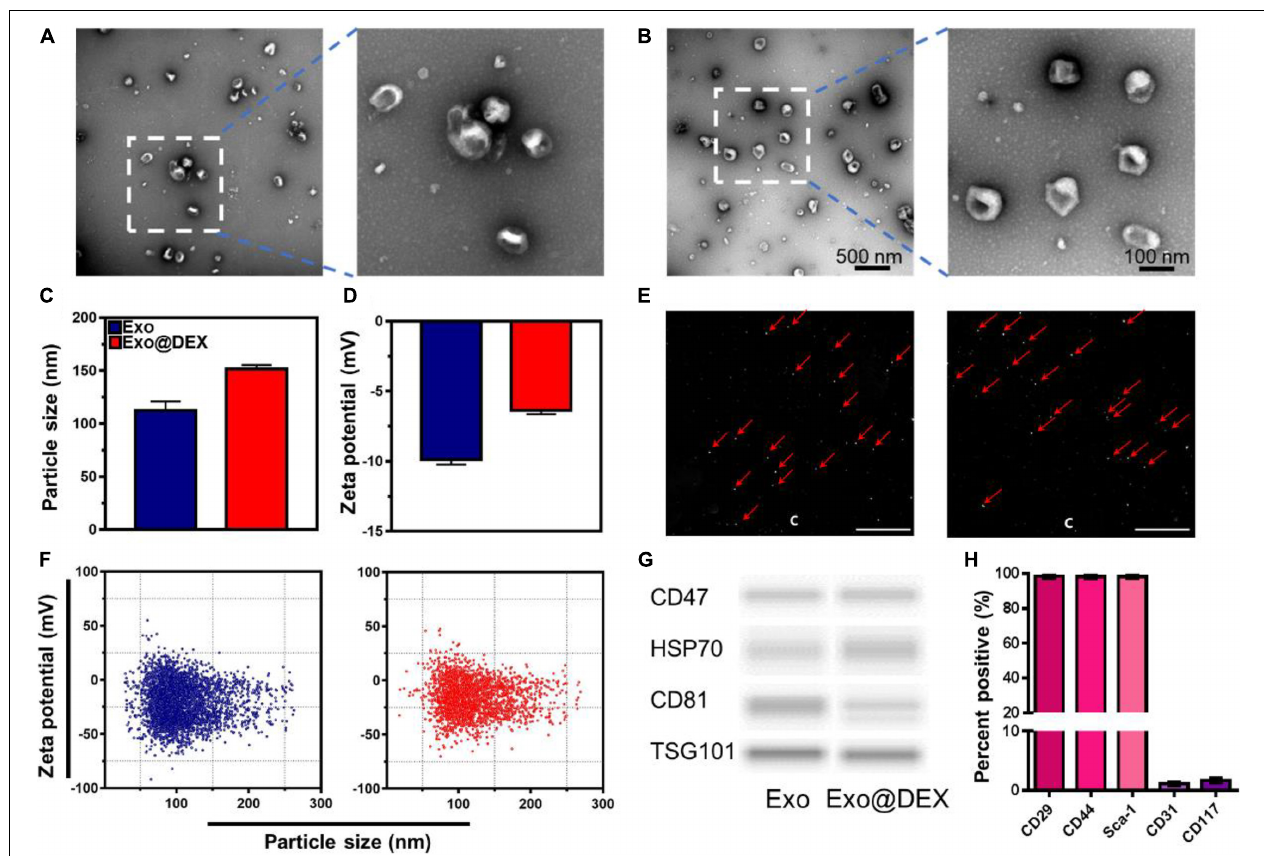
FIGURE 1 | Characterization of Exo and Exo@DEX. (A) TEM imaging of Exos and (B) DEX-loaded Exos stained with uranyl acetate. (C) The size distribution of Exos and Exo@DEX by DLS. (D) The zeta potential of Exos and Exo@DEX by DLS. (E) Screenshots of Exo and Exo@DEX detection by NTA. (F) The size distribution and zeta potential of Exos and Exo@DEX by NTA. (G) Western blot analysis of Exos and Exo@DEX. CD47, HSP70, CD81, and TSG101 are markers for Exos. (H) Quantitative analysis of MSC markers of CD29, CD44, Sca-1, CD31, and CD117.